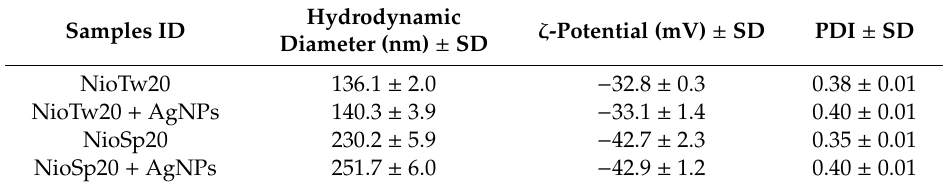
Table 1. Hydrodynamic diameter, ζ -potential, and polydispersity index (PDI) of di ff erent niosomal formulations. NioTw20: niosomal formulations by Tween 20, NioSp20: niosomal formulations by Span 20.